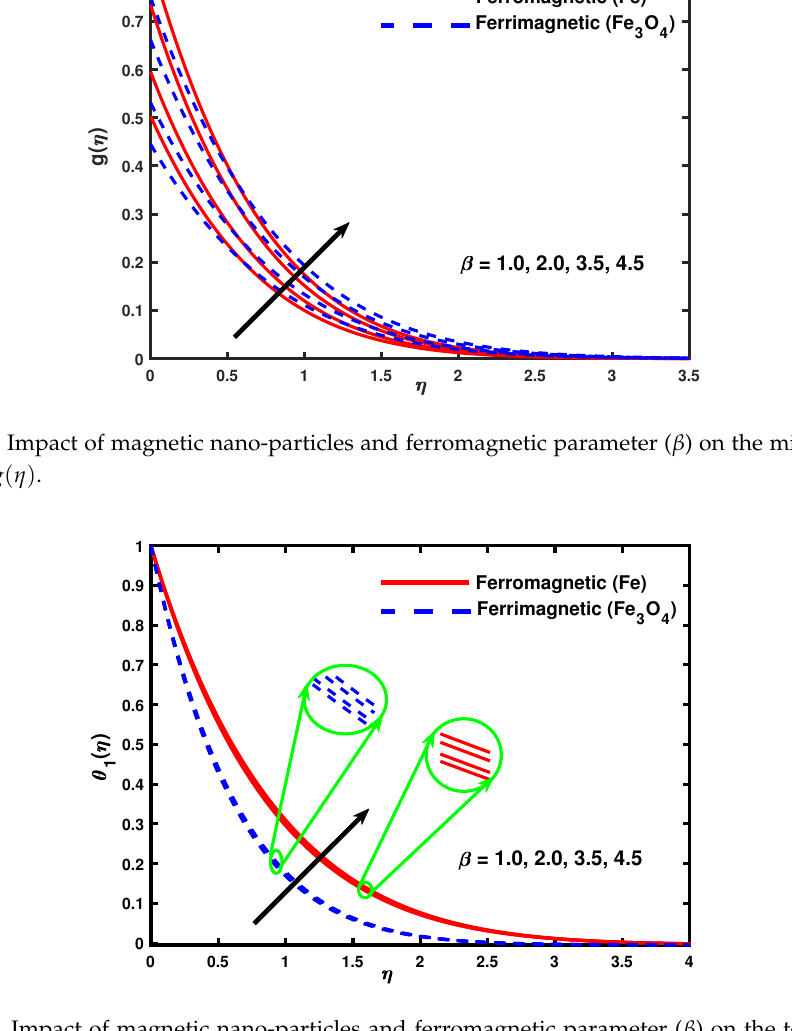
Figure 7. Impact of magnetic nano-particles and ferromagnetic parameter ( β ) on the temperature profile θ 1 ( η )